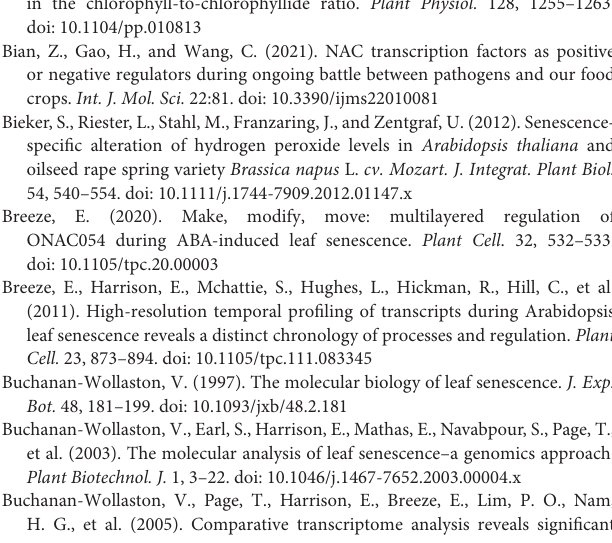
corresponding with the top 20 enrichment levels are shown. GO term are shown along the vertical axis. In contrast, the horizontal axis represents the enrichment factor, i.e., the ratio of the number of genes/transcripts (sample number) enriched in this pathway relative to the number of annotated genes/transcripts (background number). The greater the enrichment factor, the greater the degree of enrichment. The size of the point indicates the number of genes in this pathway, while the colors of the points correspond to different P -value ranges. Supplementary Figure 5 | Scatter diagram based on the Kyoto Encyclopedia of Genes and Genomes (KEGG) pathway enrichment analysis of the senescence-associated genes (SAGs) shared by darkness and salt-induced leaf senescence on day 2 ( A for 3,011 genes), 4 ( B for 3,787 genes), and 6 ( C for 4,419 genes) in detached Medicago truncatula leaves. Only the KEGG pathways within the top 20 enrichment levels are displayed. Pathway names are shown along the vertical axis, while the horizontal axis represents the enrichment factor, i.e., the ratio of the number of genes/transcripts (sample number) enriched in this pathway relative to the number of annotated genes/transcripts (background number). The greater the enrichment factor, the greater the degree of enrichment. The size of the point indicates the number of genes in this pathway, while the colors of the points correspond to different P-adjust value ranges. Supplementary Figure 6 | Scatter diagram based on the Kyoto Encyclopedia of Genes and Genomes (KEGG) pathway enrichment analysis of the senescence-associated genes (SAGs) in Figure 5 for up-regulated (A) and down-regulated genes (B) . Supplementary Figure 7 | The maSigPro analysis of Differentially expressed senescence-associated genes (SAGs) in all samples. The horizontal axis represents specific samples, the vertical axis represents the expression values after treatment log10(x + 1), and the different colored lines represent the trend of different genes in all samples. Supplementary Figure 8 | A hypothetical network of transcription factor MTR_3g088110. It showed the predicted potential target genes of transcription factors MTR_3g088110 across three time points: MTR_3g088110-2, MTR_3g088110-4, and MTR_3g088110-6 display the genes from day 2 Figure 4A 3011genes, day 4 Figure 4B 3787genes, and day 6 Figure 4C 4419genes co-regulated with MTR_3g088110, respectively. Supplementary Figure 9 | Differentially expressed senescence-associated genes (SAGs) related to physiological and biochemical indicators. (A) The number of genes from darkness and salt treatment enriched 1546 SAGs was associated with physiological and biochemical changes during salt induced leaf senescence. (B) Short Time-series Expression Miner (STEM) analysis of the genes in (A)